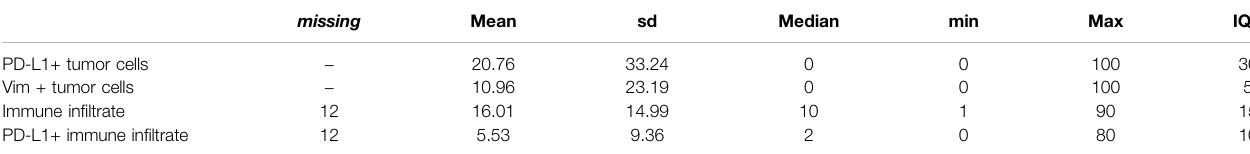
TABLE 2 | Descriptive statistics of IHC biomarkers. missing Mean